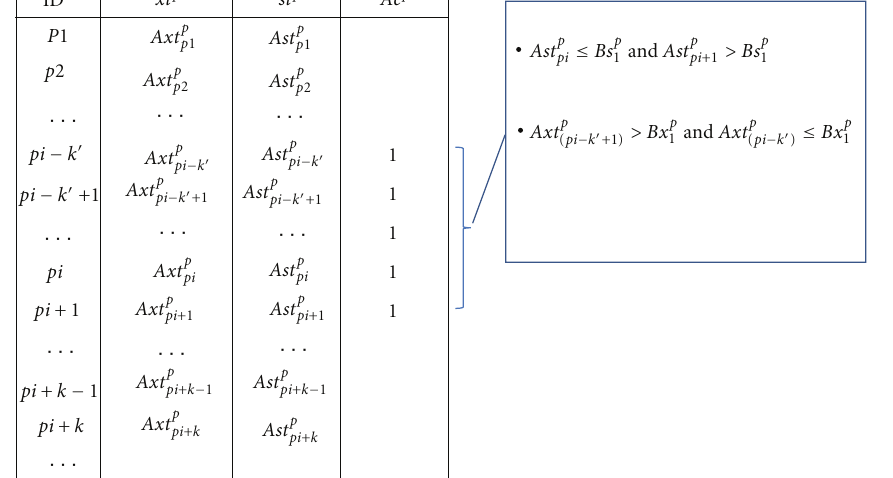
Figure 2: Find the first zone ( ej = 1) from the order of the unknown dataset A at Case II. According to the score and rank, those two values of the objects were defined as the lower-bound and upper-bound of this region, respectively. A zone of “1” is used to define some of the objects that are between pi − k (cid:3) and pi + 1. Therefore, we defined the zone of the object as { Ac